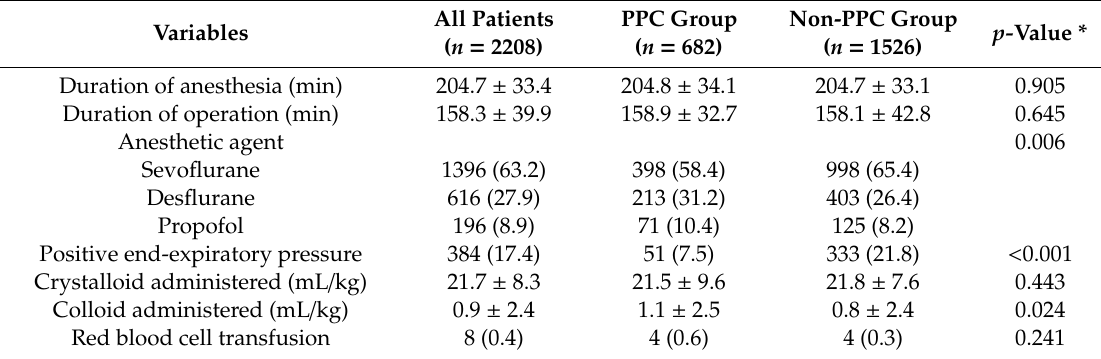
Table 2. Intraoperative data.